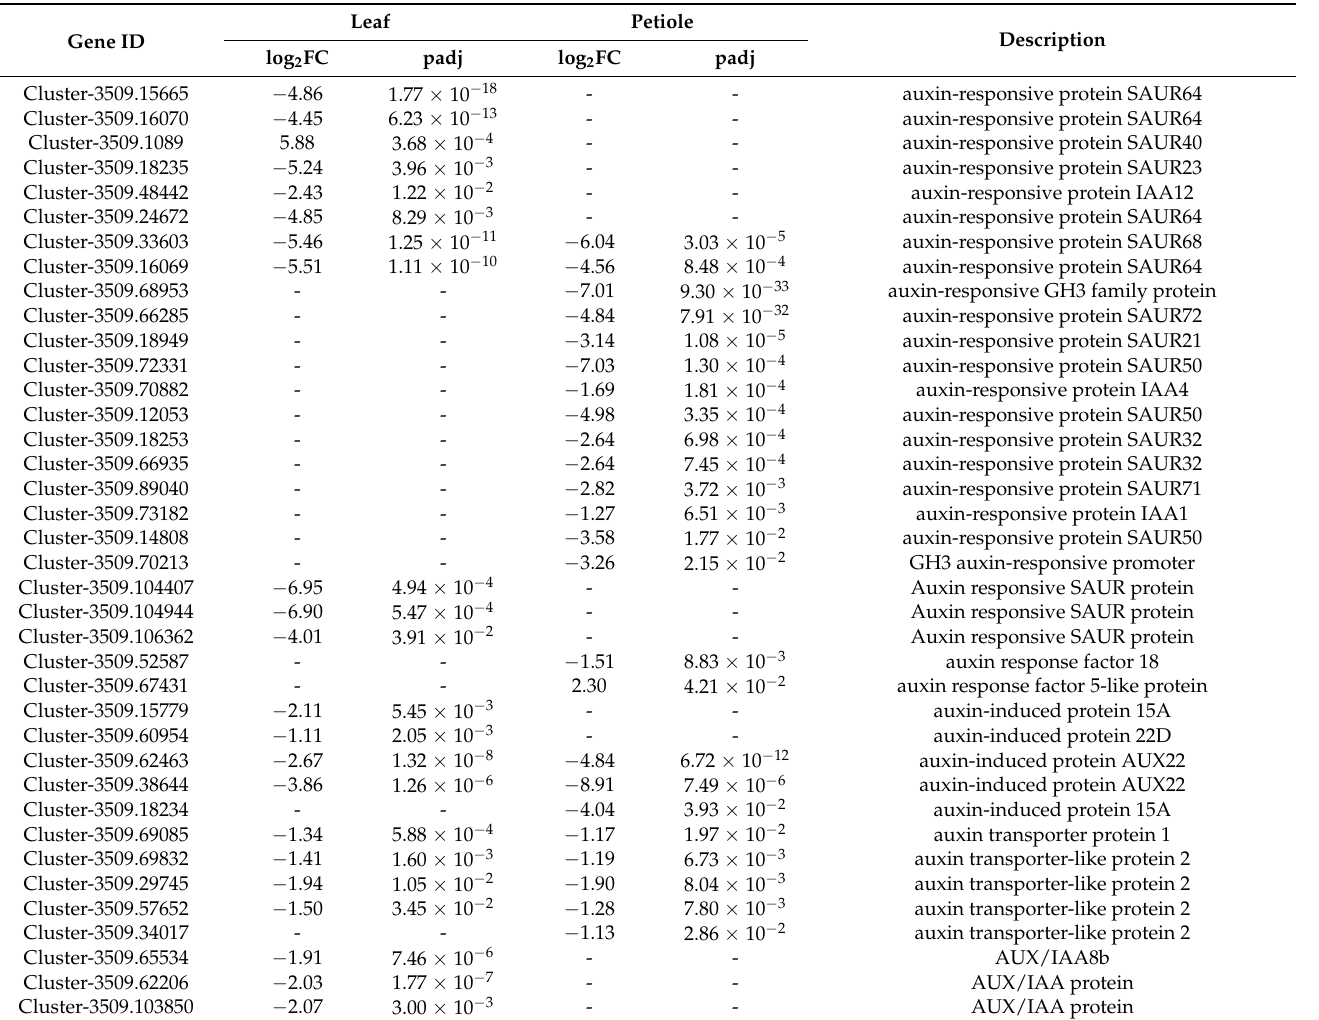
Table 3. Auxin-related DEGs identified in salt-stressed water